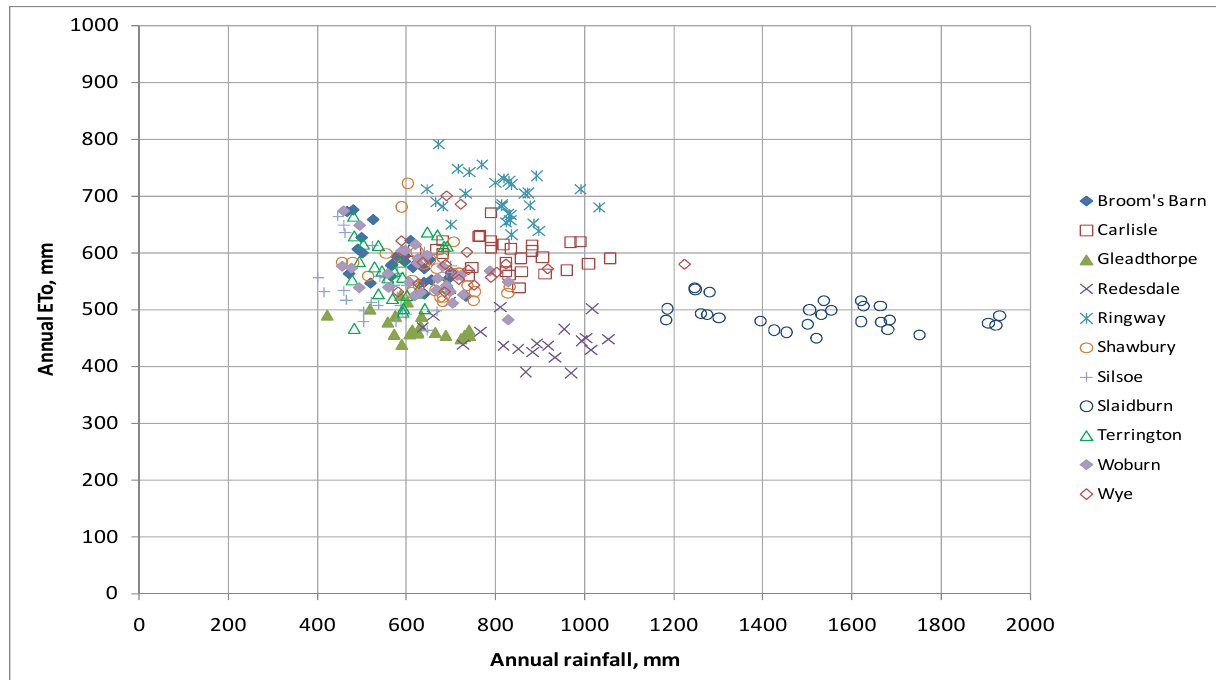
Figure 1. Distribution of annual rainfall (mm) and ETo (mm) for 291 station-years of data for 11 stations in